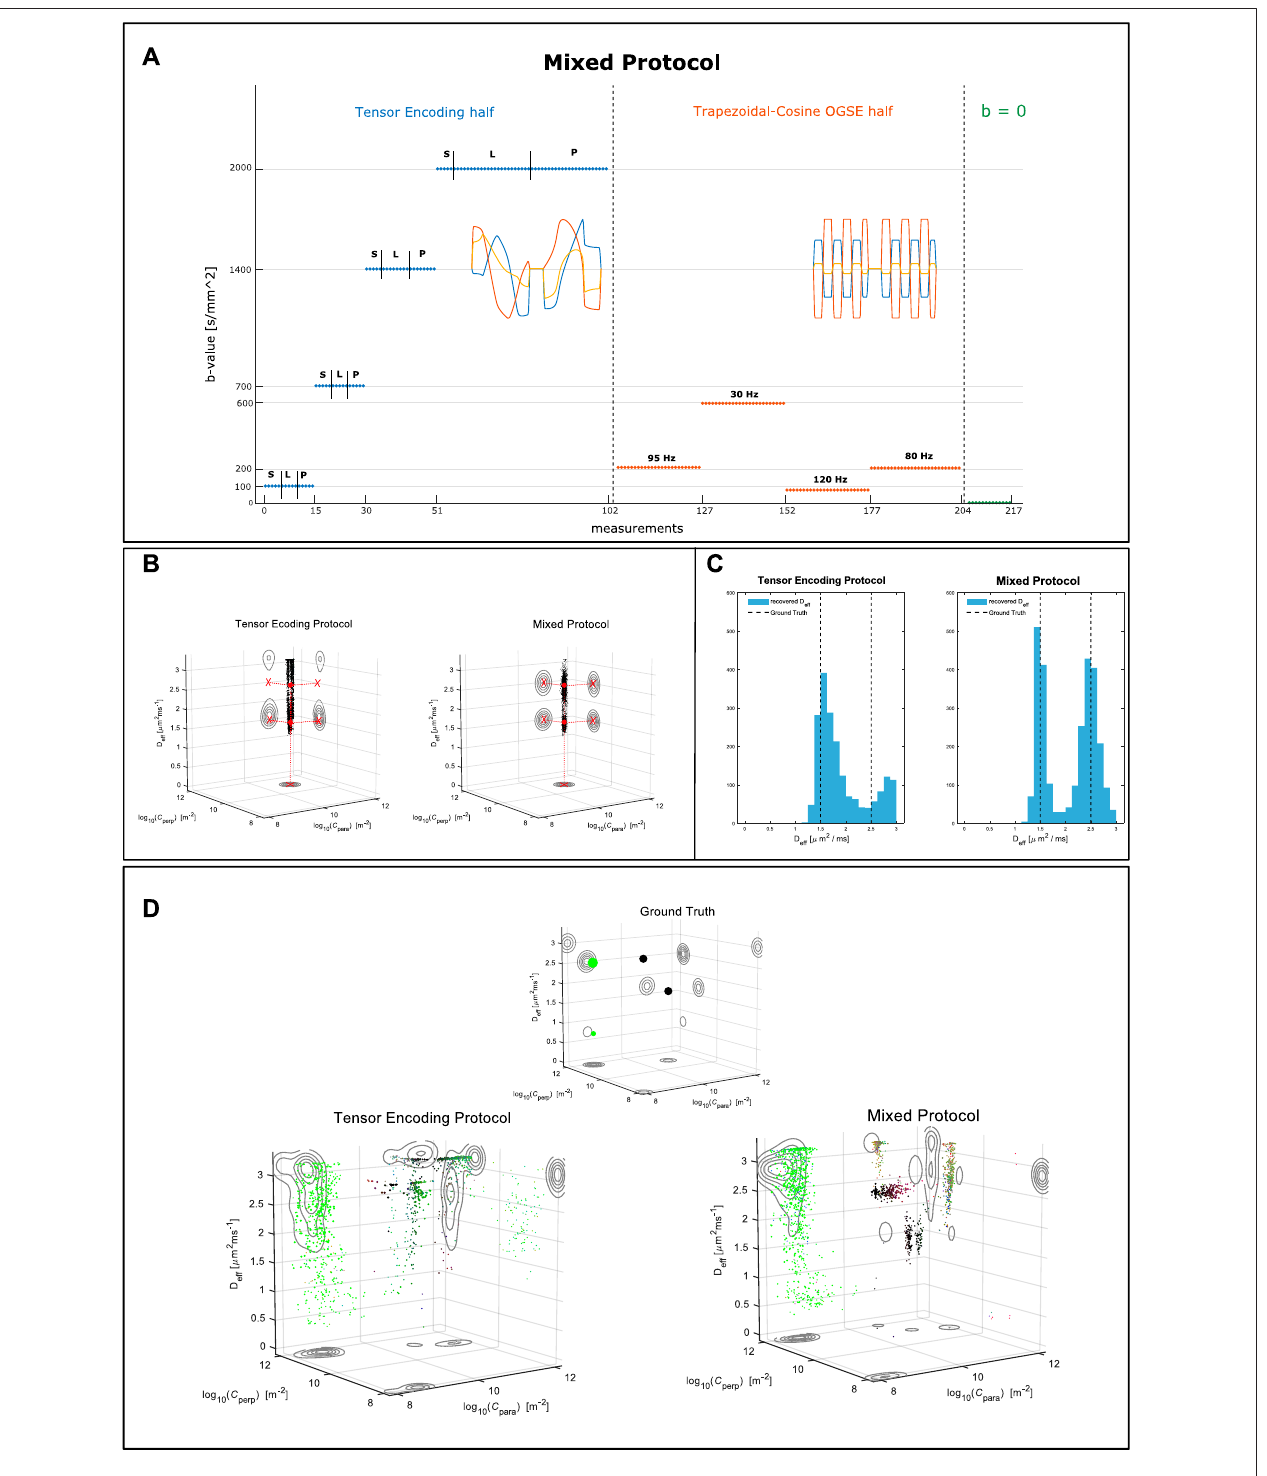
FIGURE4|(A) Layoutofthe mixed protocol.102measurementsconsistofLTE,PTE,andSTEwaveformsasde fi nedinthe tensorencoding protocol,butwiththeir directions redistributed over the sphere to achieve more uniform directional sampling. Another 102 measurements consist of Trapezoidal Cosine Oscillating Gradient Spin Echo waveforms oscillating at 4 different frequencies. The last 13 measurements had null diffusion gradient strength. (B) Results of inverting Eq. 11 for a simple system consisting of two equally weighted water pools with identical geometries but different water diffusivities. Left, data encoded with the tensor encoding protocol. Right, data encoded with the mixed protocol. The red fi lled dots depict the ground truth values in the 3D plot, while the red crosses show the ground truth